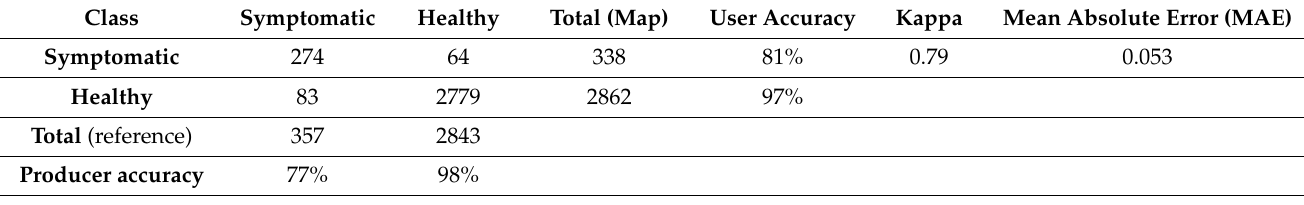
Table 4. Summarized performance results of the Sentinel-2 decline detection model, based on the assessment conducted using independent validation data.